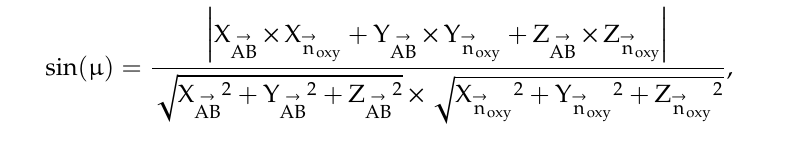
Figure 5. Image of reference points in the image sensor plane.